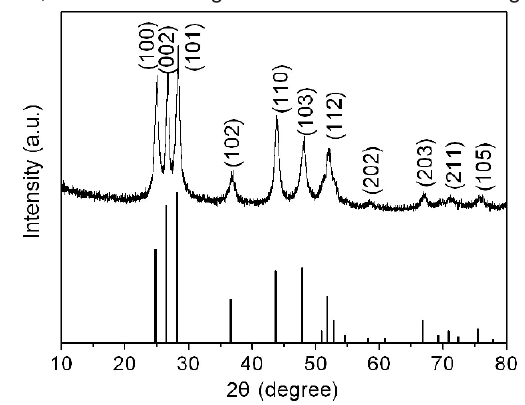
Figure 1. XRD pattern of the flower-like CdS architectures obtained at 160 o C for 12